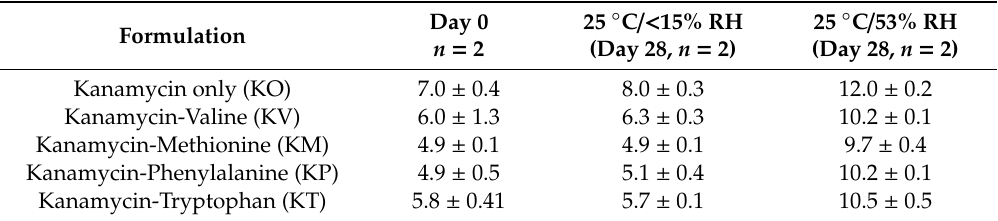
Table 4. Summary of water content in the di ff erent formulations on day 0 and day 28 when stored at 25 ◦ C /< 15% RH or 25 ◦ C / 53% RH. Values are expressed as mean ± standard deviation.